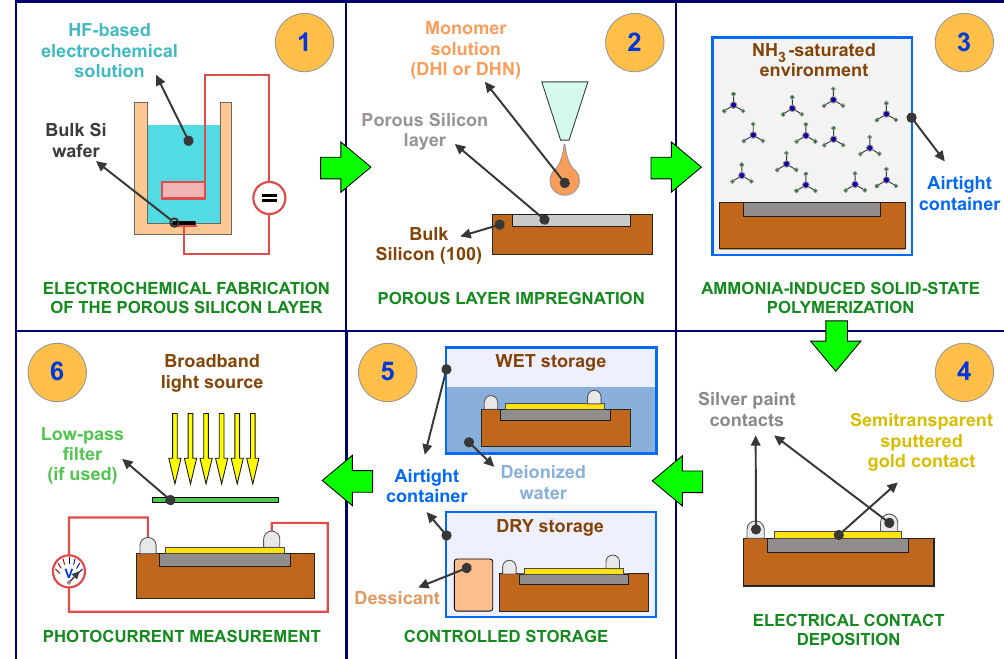
Figure 4. Schematic of the experimental steps of this study. (1) Fabrication of the porous layer, (2) impregnation of the porous layer using an alcoholic monomer solution, (3) polymerization of the monomers by keeping the samples in an ammonia-saturated environment, (4) deposition of the electrical contact, (5) wet or dry storage of the samples, (6) measure of the photocurrent